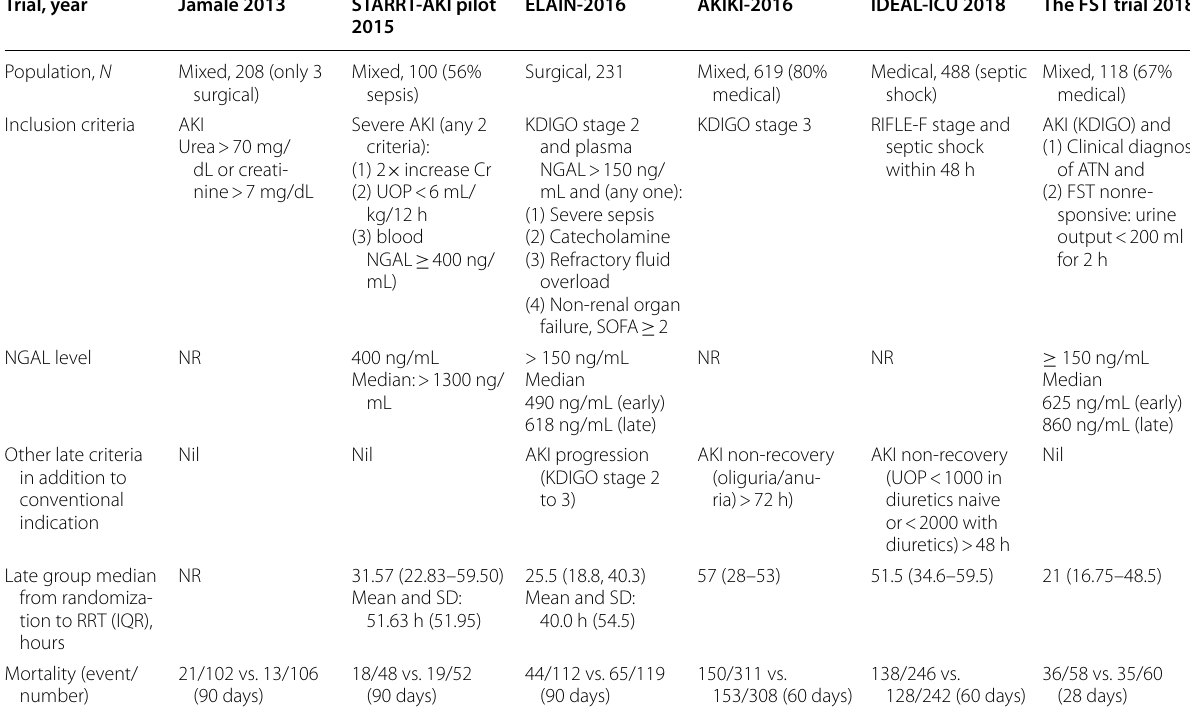
Table 3 Six major randomized controlled trials included in sensitivity analysis for examination of the watchful waiting